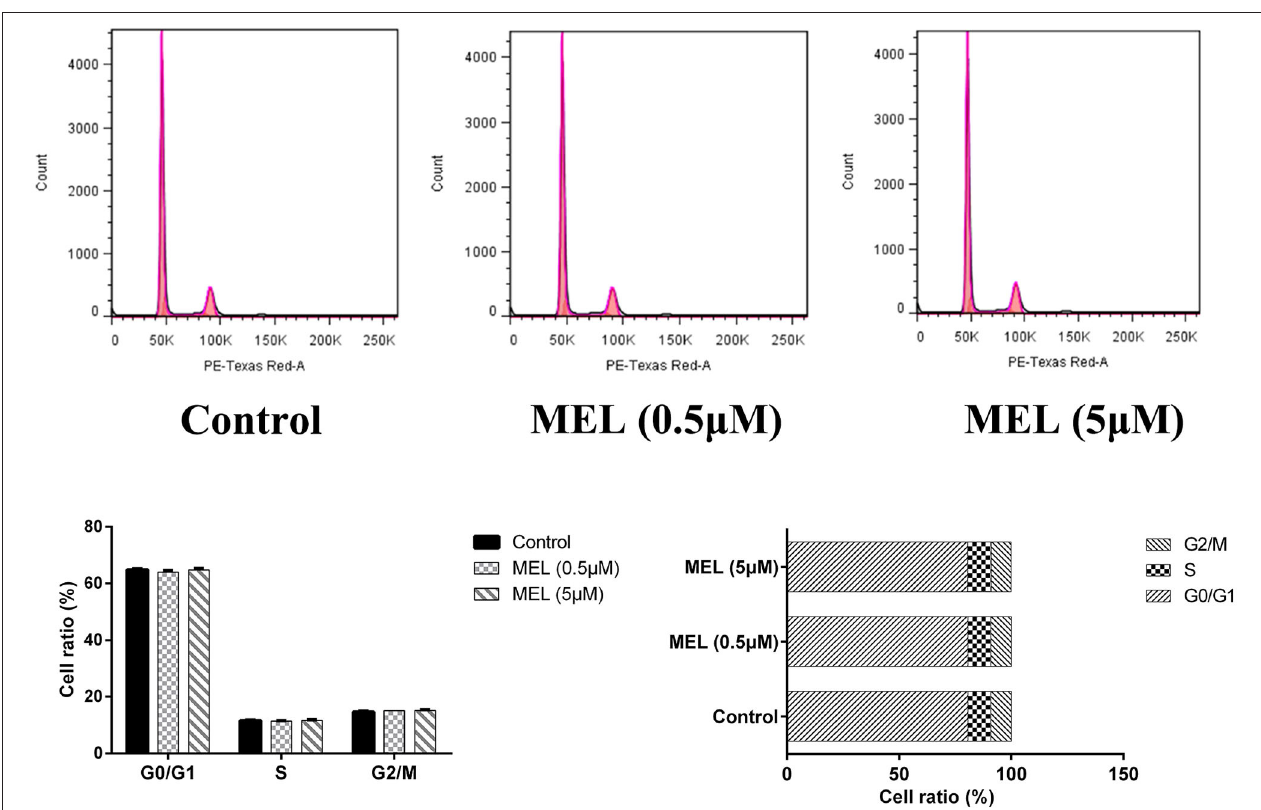
FIGURE 6 | The effect of meloxicam on the cell cycle distribution of bovine endometrial epithelial cells. MEL, meloxicam. The cells were treated with MEL (0.5 and 5 µ M) for 24h. The cell cycle distribution was detected by flow cytometry and was analyzed by FlowJo software 7.6 to obtain the relative number of cells in each phase of the cell cycle. All data were presented as means ± SEM ( n =